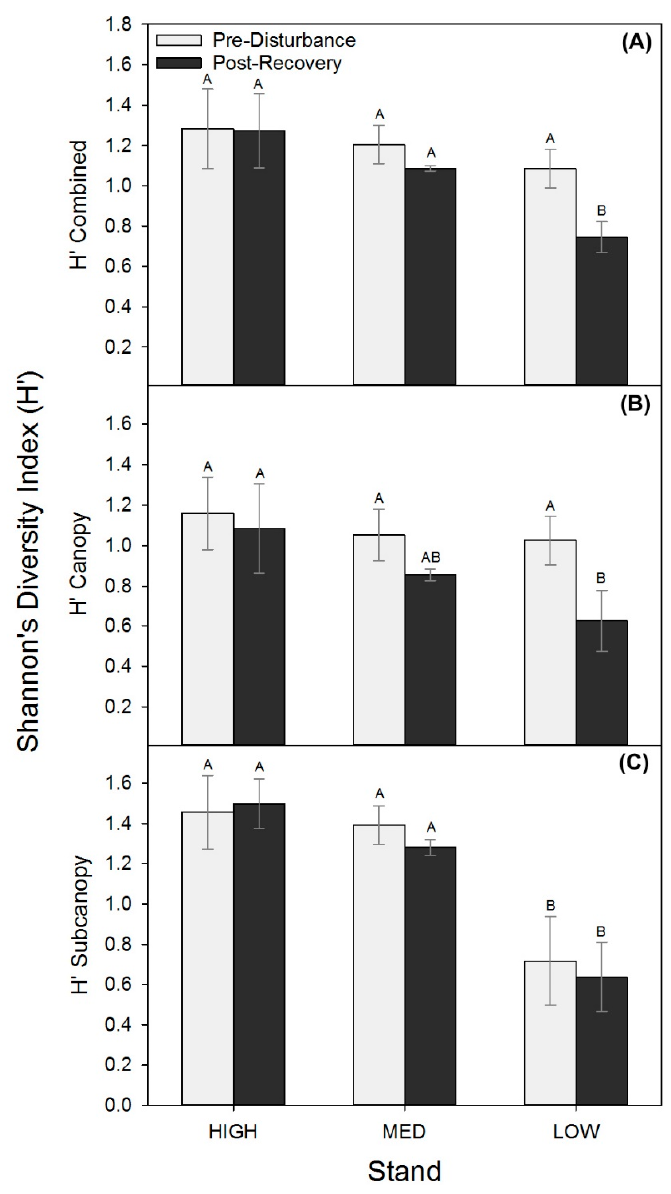
Figure 3. Shannon’s diversity index (H’; mean ± SE), combined ( A ) and for canopy ( B ) and subcanopy ( C ) strata before (2001 or 2006) and following recovery (2016) for each treatment stand.